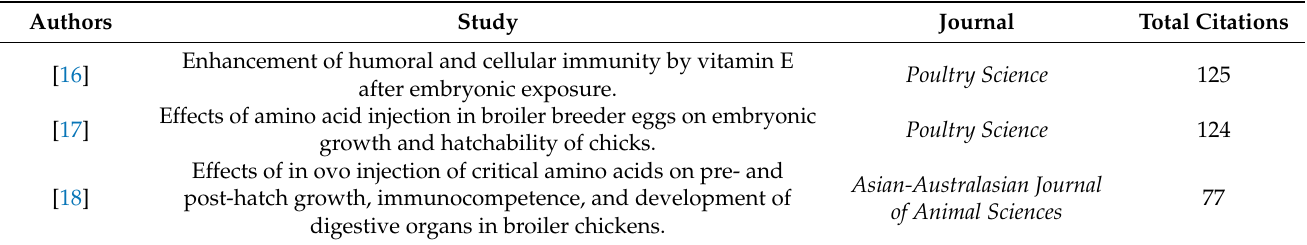
Table 2. The 10 most cited studies between 1985 to